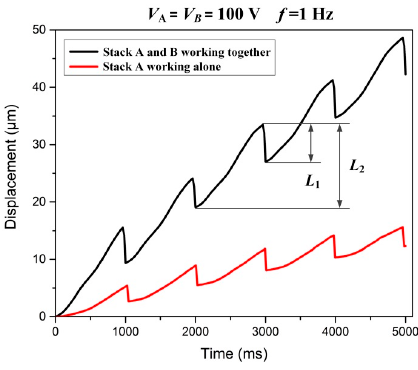
Figure 8. Motion displacement of two kinds working modes: stack A working alone, and stack A and B working together.